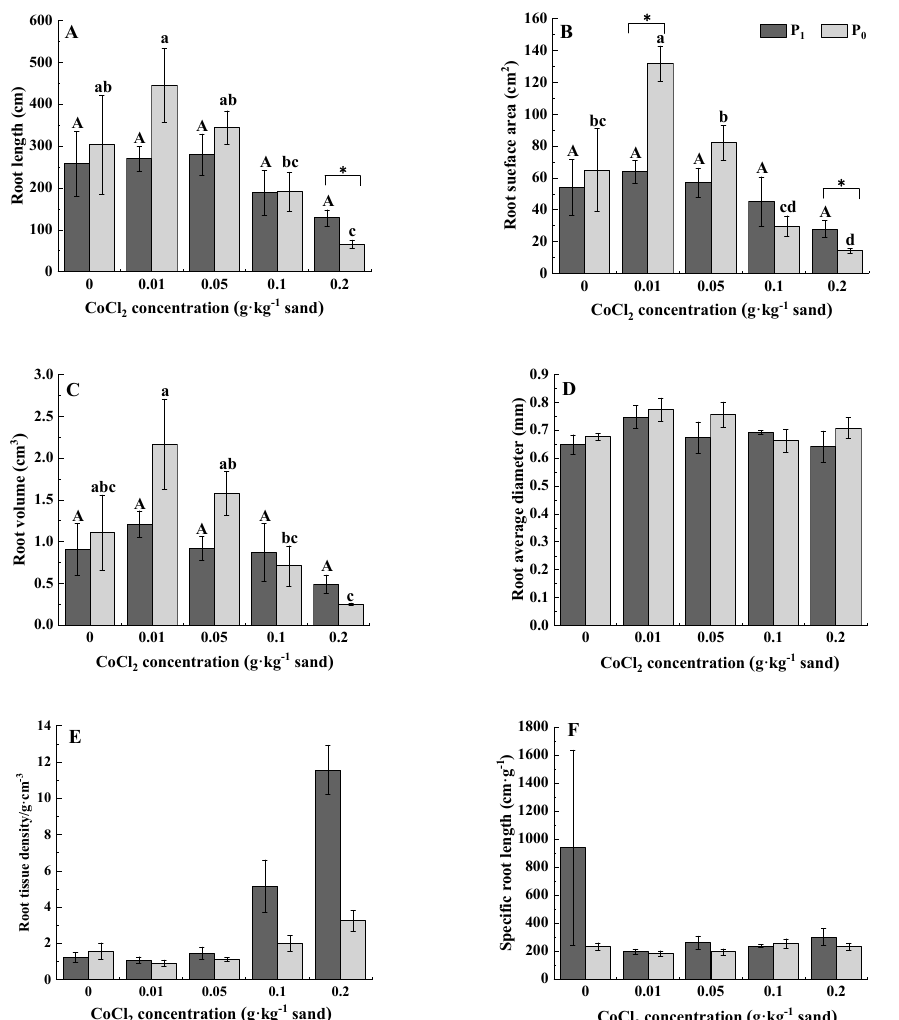
Figure 2. Differences in the root length ( A ), root surface area ( B ), root volume ( C ), root average diameter ( D ), root tissue density ( E ), and specific root length ( F ) between the two groups, namely phosphorus supply (1 mmol · KH 2 PO 4 , P 1 ) and no phosphorus supply (0 mmol · KH 2 PO 4 , P 0 ), treated with different concentrations of exogenous CoCl 2 . Bars (mean ± standard error) accompanied by the same lowercase letter(s) are not significantly different at the 5% probability level. Different capital letters indicate significant differences between different additive concentrations under normal P supply conditions, while different lowercase letters indicate significant differences between different additive concentrations under low-P stress. * Indicates that the same additive concentration is significantly different under different P supply